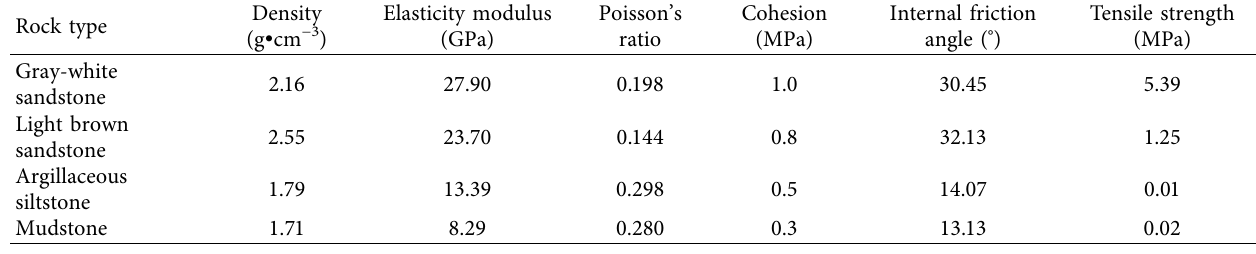
Table 1: Physical and mechanical parameters of the rock mass in the grottoes.